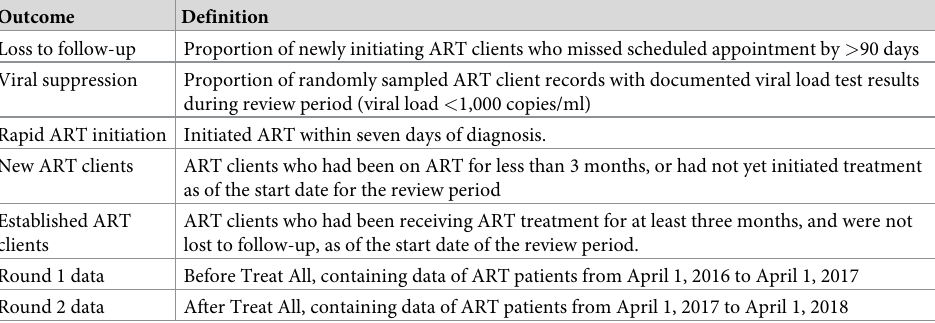
Table 1. Client types and key outcome